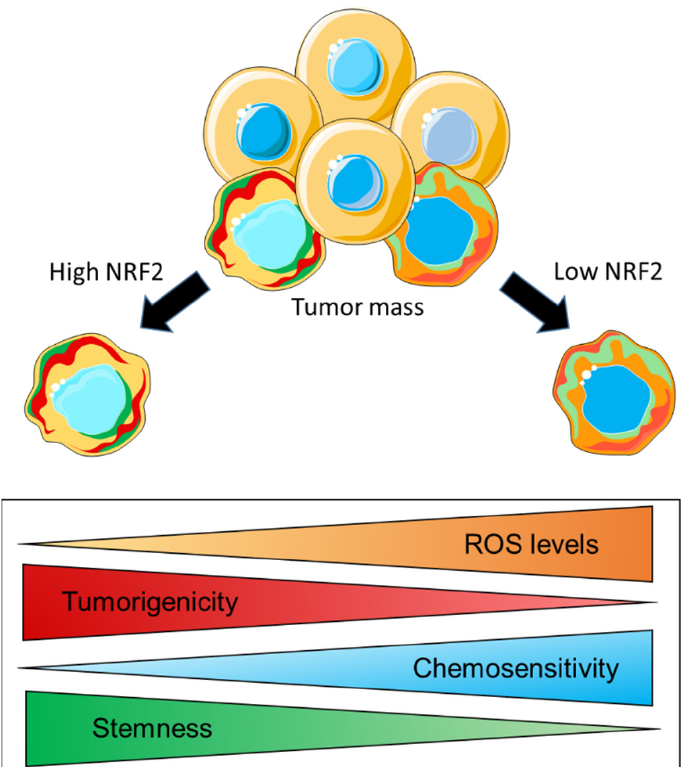
Figure 6. NRF2 regulates crucial aspects of CSCs’ biology by controlling their redox homeostasis. As shown in this schematic representation, within the tumor mass, normal cancer cells and CSCs coexist. Among them, two different phenotypes are observed, most likely reflecting the extent of NRF2 activation. The CSC on the bottom left is characterized by high NRF2 content, low intracellular ROS levels, and high stemness and tumorigenicity but low chemosensitivity. On the opposite side of this spectrum, the CSC on the bottom right has low NRF2 content, low tumorigenicity, and a high content of intracellular ROS, resulting in high differentiation and high chemosensitivity. The figure was created starting from freely available cartoons (https://smart.servier.com/smart_image/in-situ- cancer/, accessed on 27 June